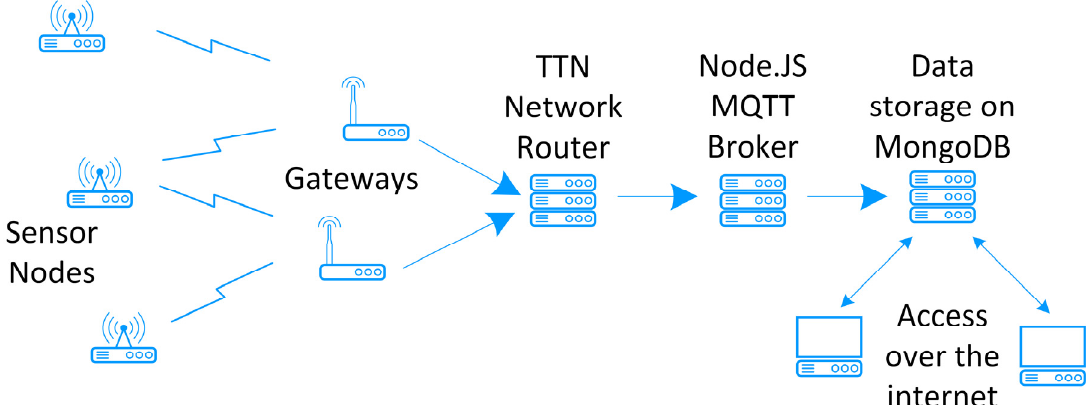
Figure 9. Overview of data processing.